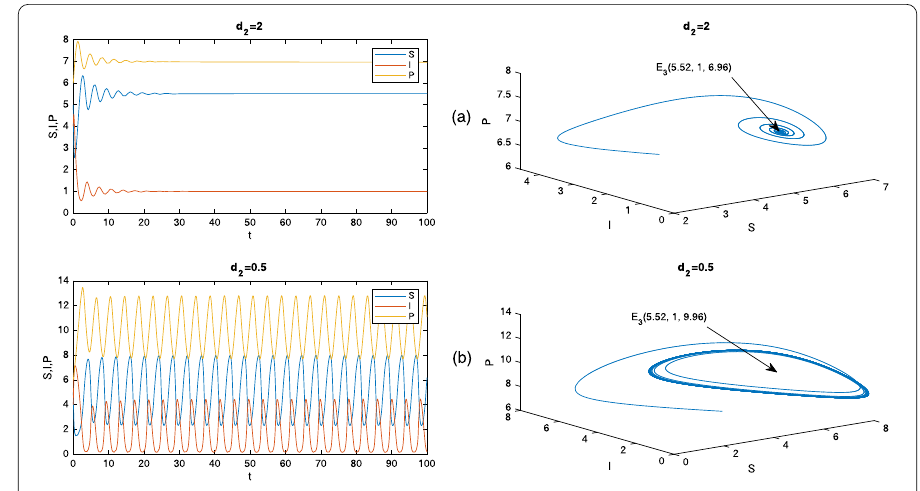
Figure 15 Time series and phase diagram of the fractional-order model (3) with different values of infected prey’s death rate ( d 2 ) when q = 0.9